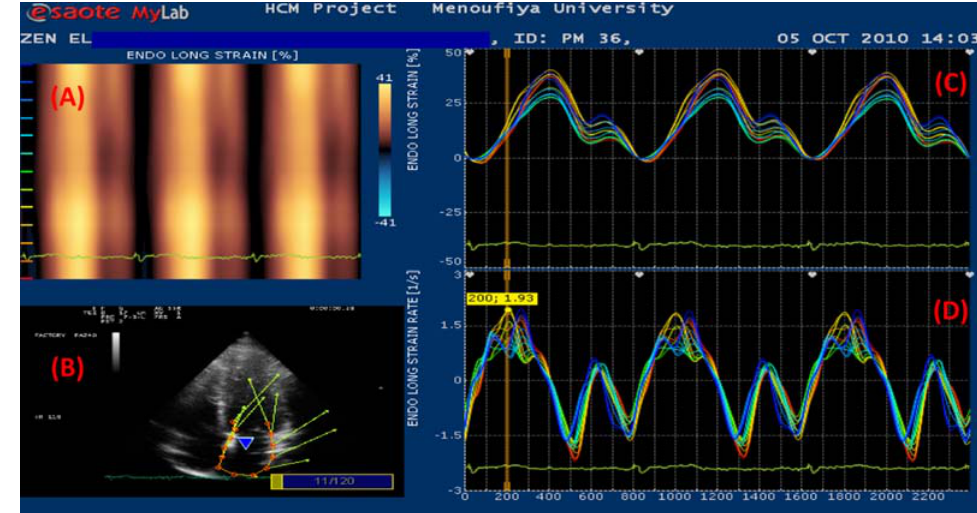
Figure 1. LA strain and strain rate using VVI. A: Curved M-mode of LA longitudinal strain. B: Tracing of the LA endocardial border in apical 4-ch view showing velocity vectors. C: Strain and D: strain rate versus time curves in septal, lateral and LA roof segments. The averaged LA SR sys is 1.9 s 2 1